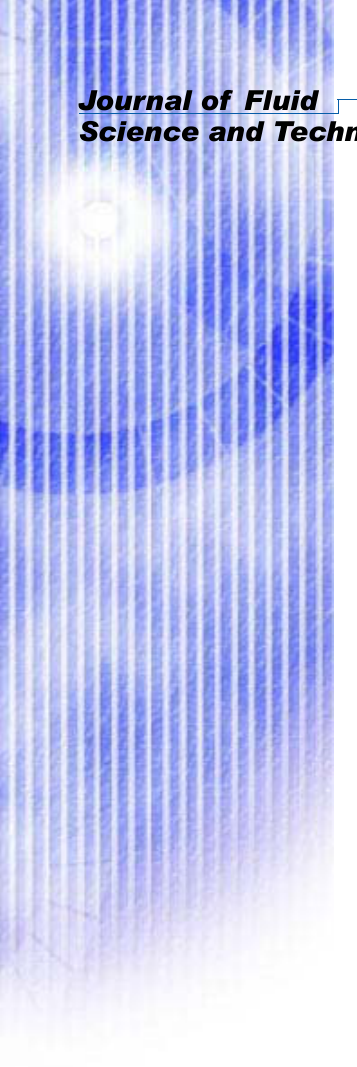
Fig. 10 Calibration of ∆ E o versus θ